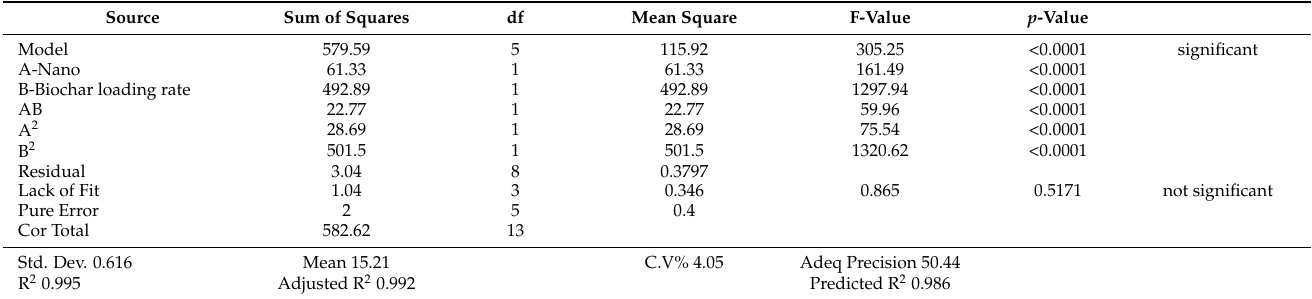
Table 3. Analysis of variance in biogas production